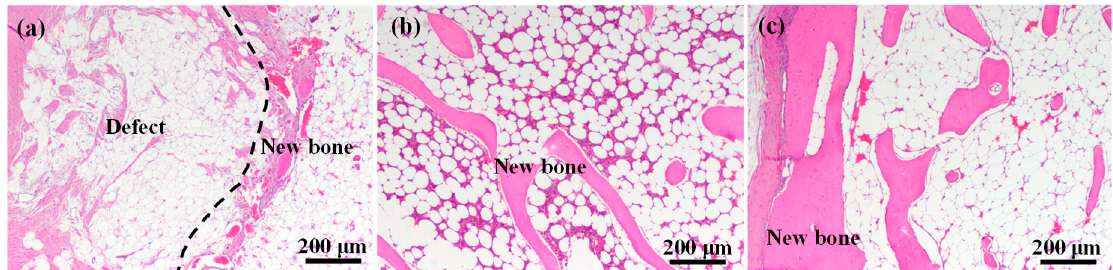
Figure 9. Images of H&E-stained bone tissue 12 weeks after implantation: ( a ) blank, ( b ) control, and ( c ) α -CSH samples.